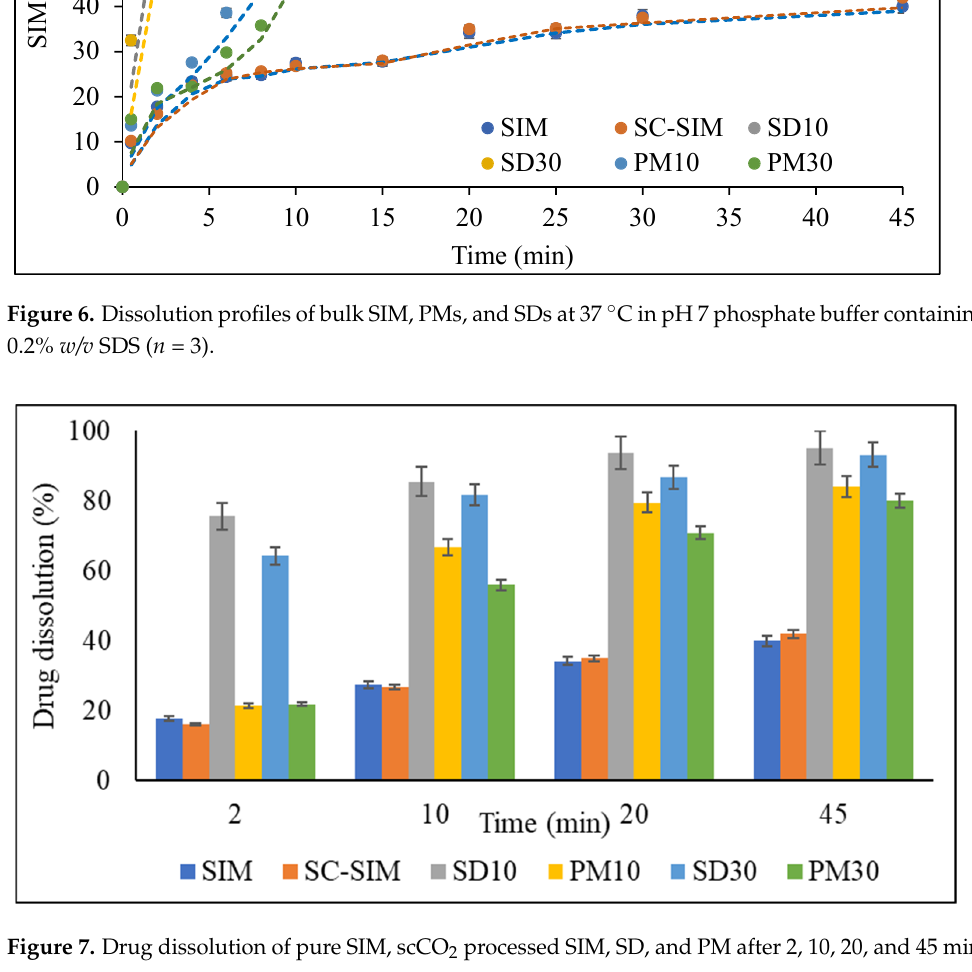
Figure 7. Drug dissolution of pure SIM, scCO 2 processed SIM, SD, and PM after 2, 10, 20, and 45 min.